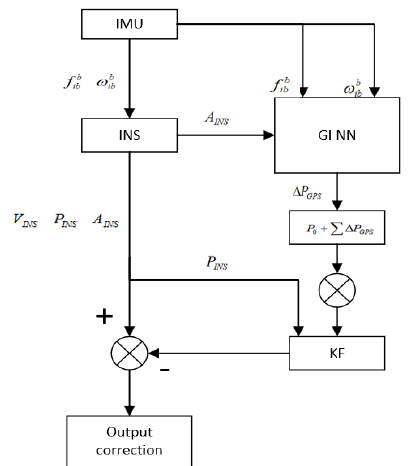
Figure 5 . GI-NN auxiliary GNSS/INS integrated navigation system structure diagram when predicting mode.